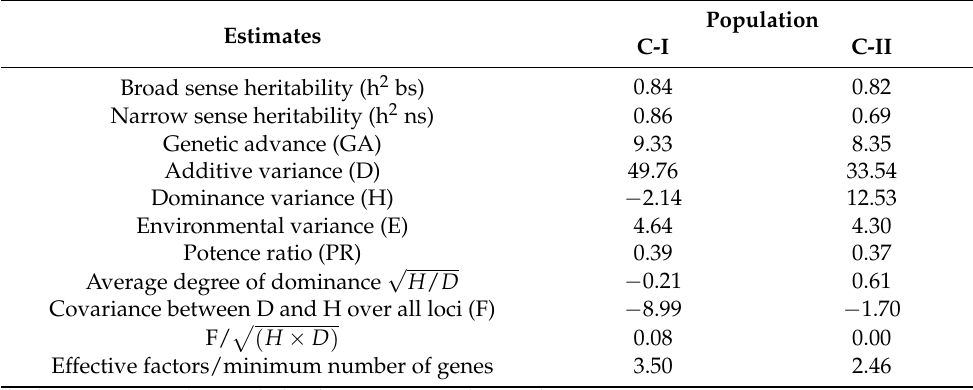
Table 7. Genetic parameters and components of variation for lesion length (cm) in two populations of Indian